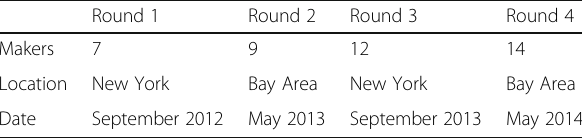
Table 2 Participant recruitment ( N = 42) and interviews (participant pool, location, date)